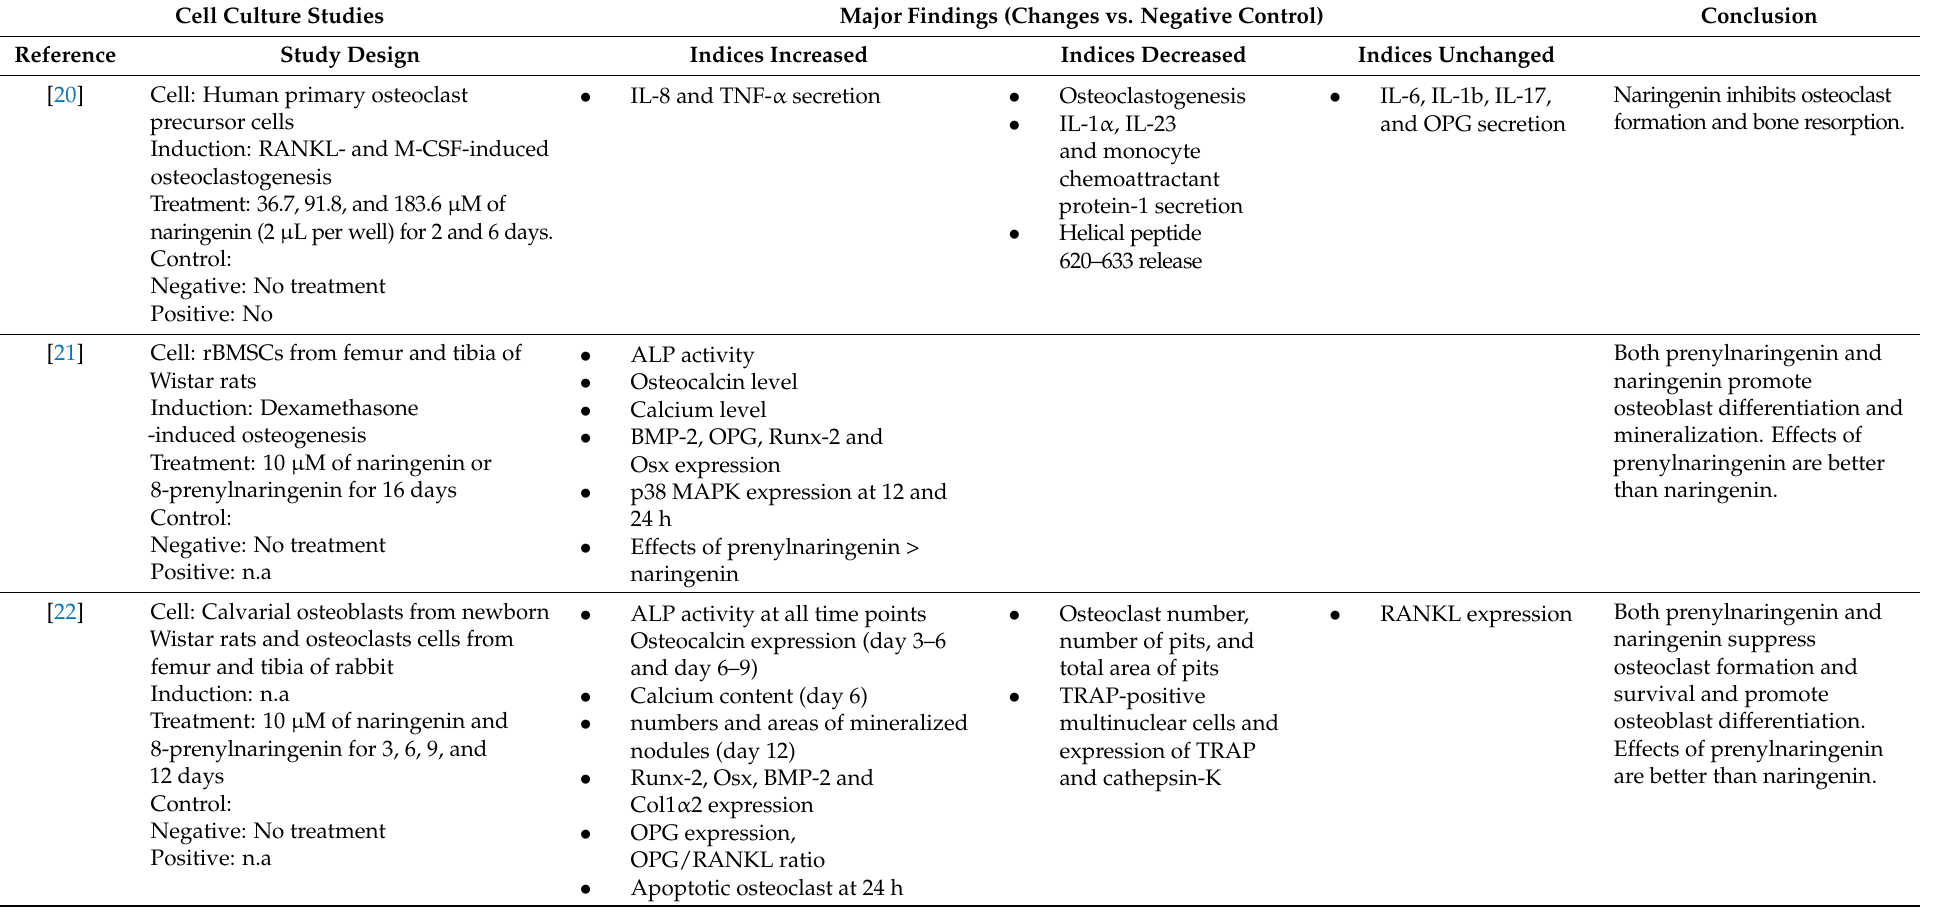
Table 1. Effects of naringenin on bone